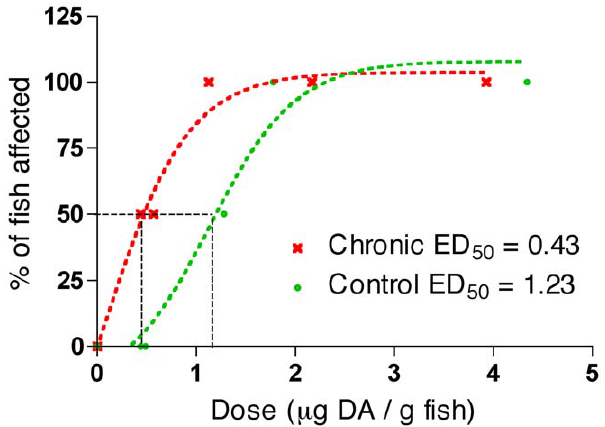
Figure 2. Dose-response relationship between intracoelomic (IC) injection doses of domoic acid (DA) and the percentage of zebrafish affected (n=4 at each dose) for chronically exposed (red line) and control (green line) zebrafish. Circular and/or spiral- swimming behaviors were used to quantify excitotoxicity in fish. The 50% Effective Dose (ED 50 )=the dose at which 50% of the fish tested were affected ( m g DA/g). The dose-response experiment was carried out at 20 weeks of exposure (one week after the last injection).